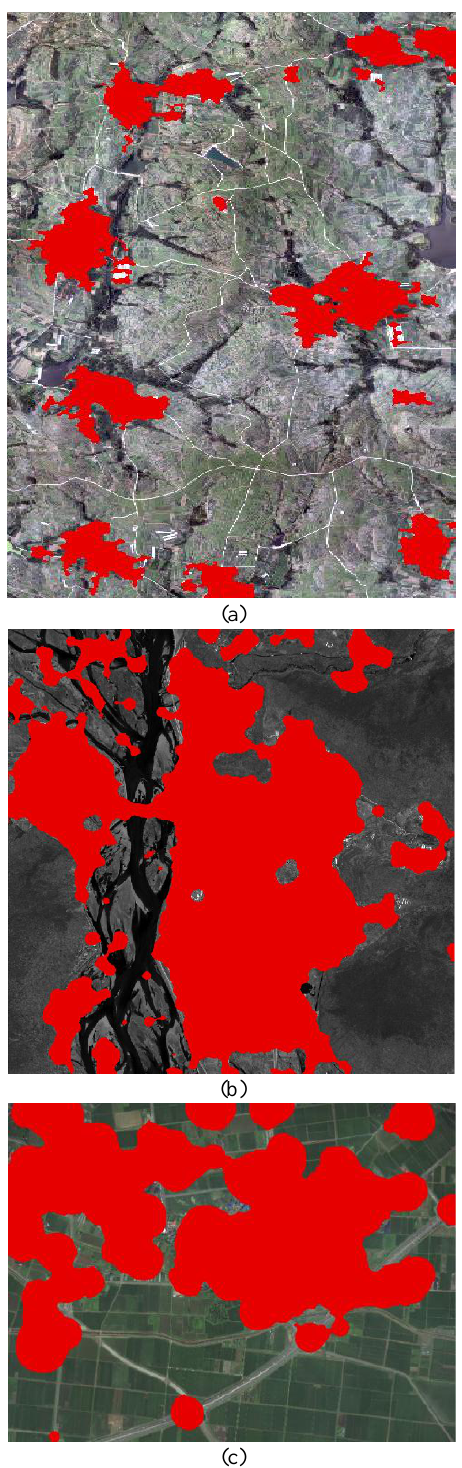
Figure 3. The extracted human settlments by our proposed method, including the first image and its result (a), the second image and its result (b), and the third image and its result (c) As far as our proposed method is concerned, values of the seven parameters of our method for the three images are listed in Table 1. Additionally, manual digitization is adopted to create reference data to verify the performances of the above two methods. In the process of full manual annotation, manual clicks should be as accurate as